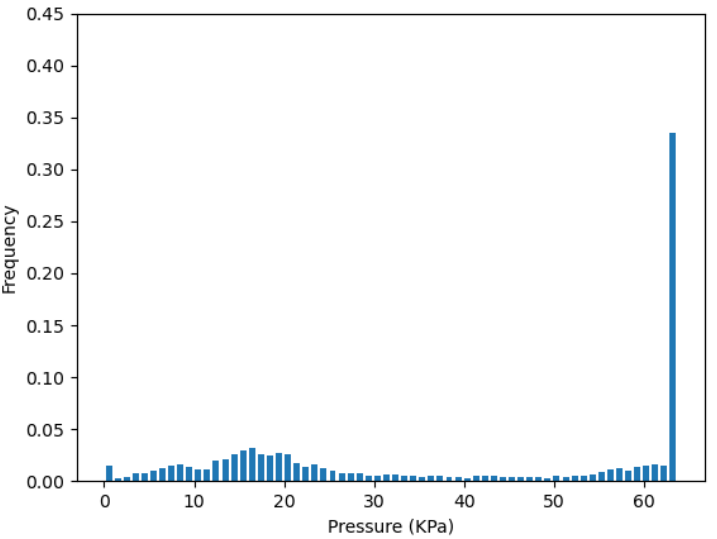
Figure 11. Pressure distribution from all sensors in C r